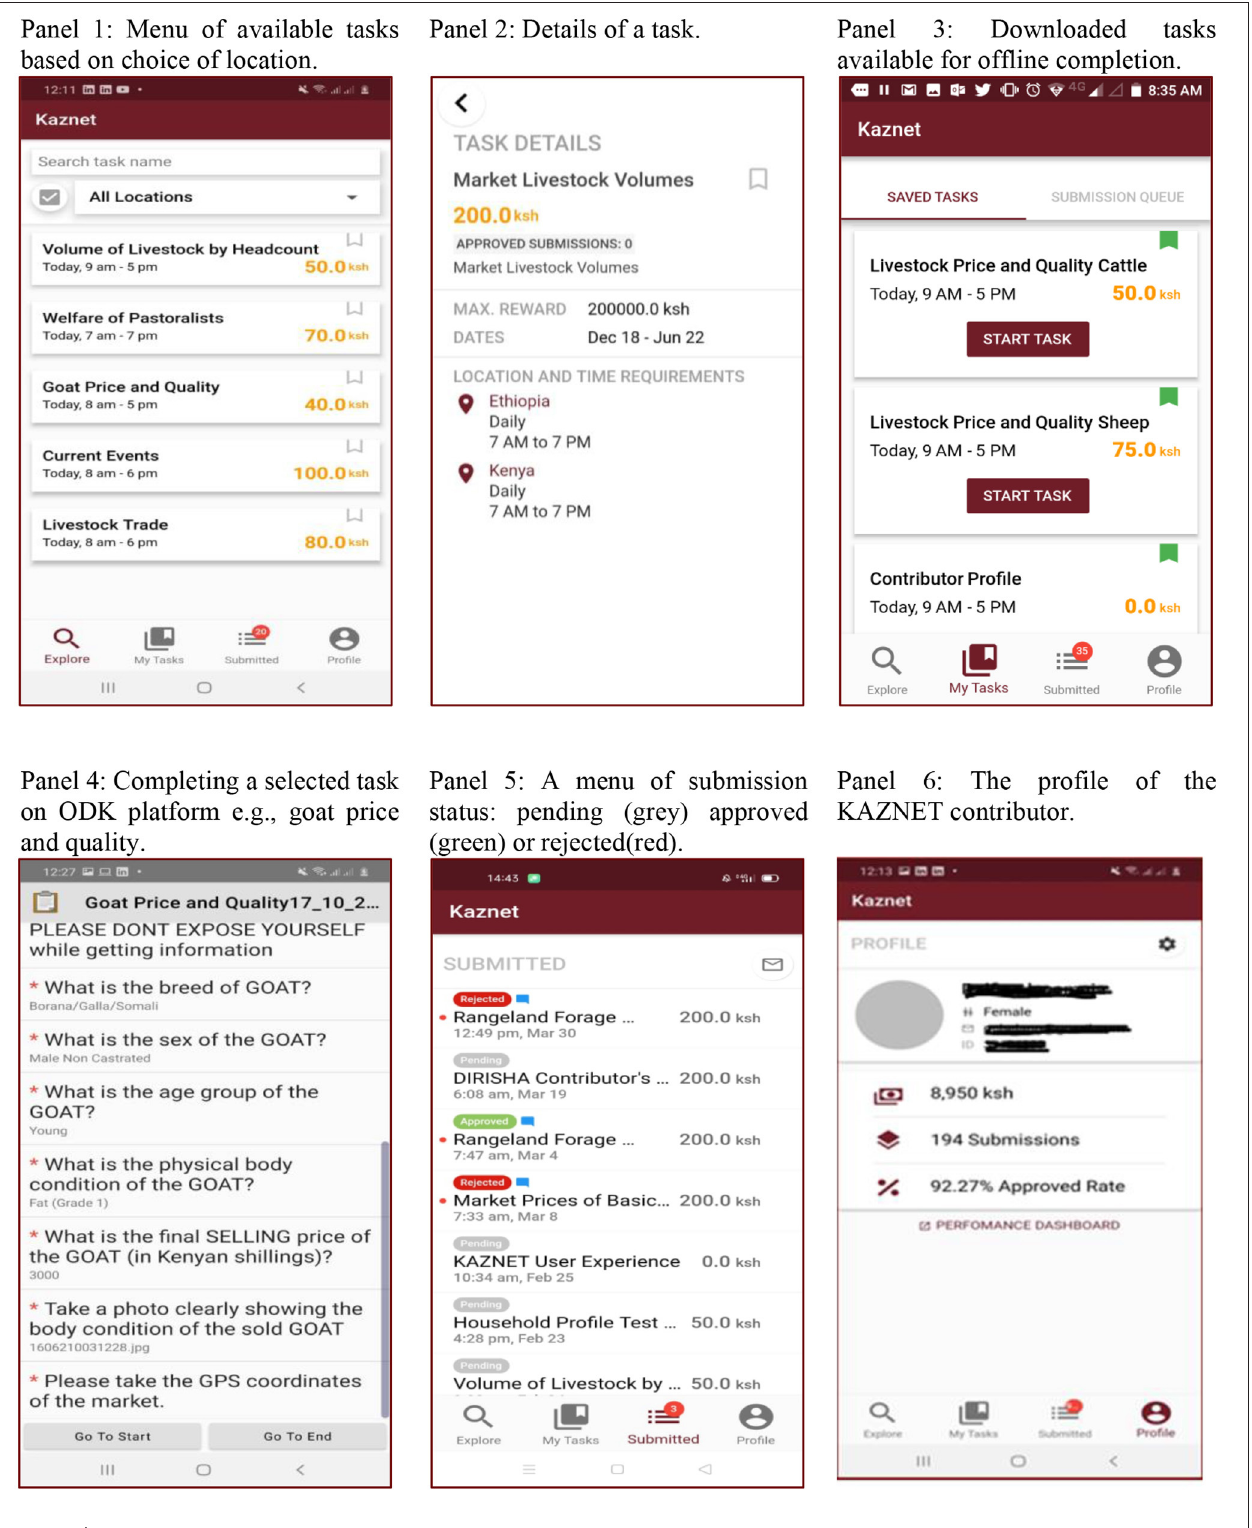
FIGURE 4 | The KAZNET platform front end